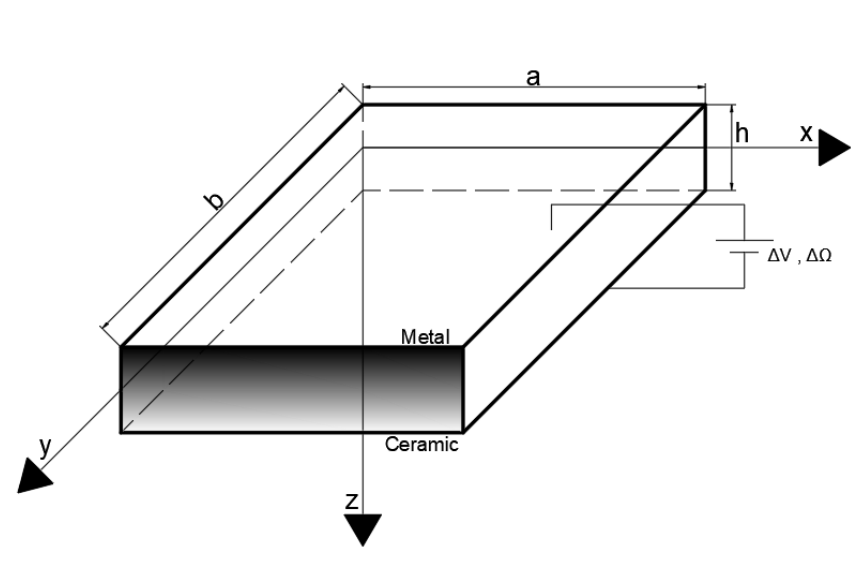
Figure 1. Functionally graded plate with applied electric ∆ V and magnetic potentials ∆Ω